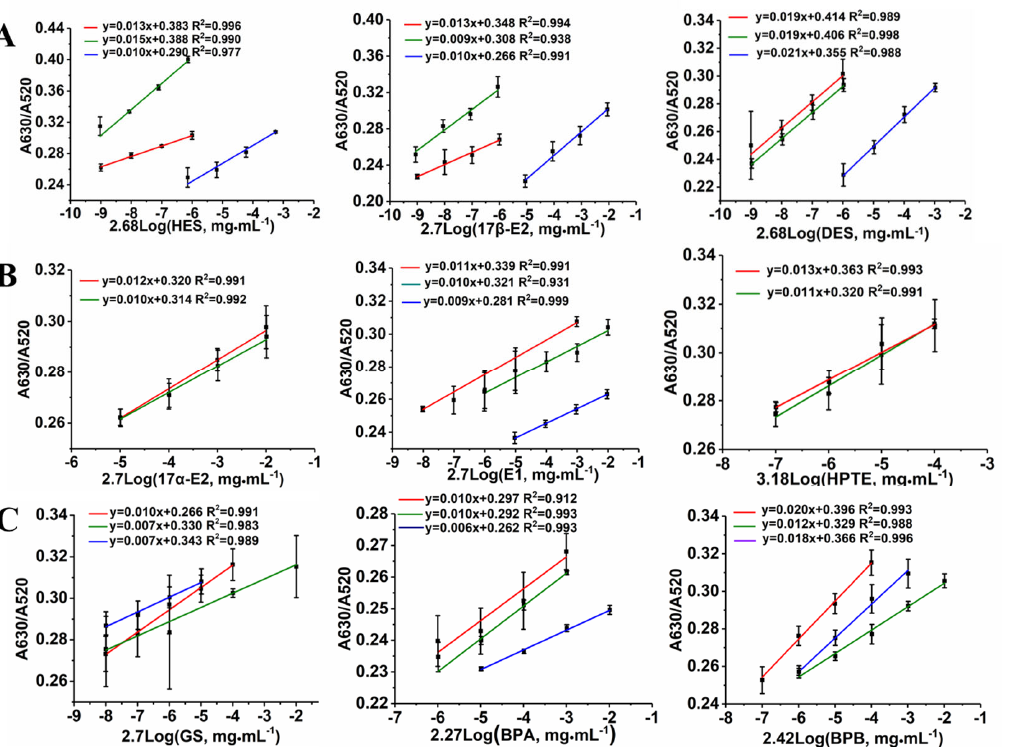
Figure 3. The standard curves of nine different estrogenic activity EDCs including linear range and linear relationship based on different ER colorimetric methods. (“Red line” represents AuNPs-ER cocktail colorimetric assay; “Green line” represents AuNPs-ER α colorimetric assay; “ Blue line ” represents AuNPs-ER β colorimetric assay). ( A ) The standard curves of DES, 17 β -E2, and HES with high estrogenic activities. ( B ) The standard curves of 17 α -E2, E1, and HPTE with moderate estrogenic activities. ( C ) The standard curves of BPA, BPB, and GS with low estrogenic activities.